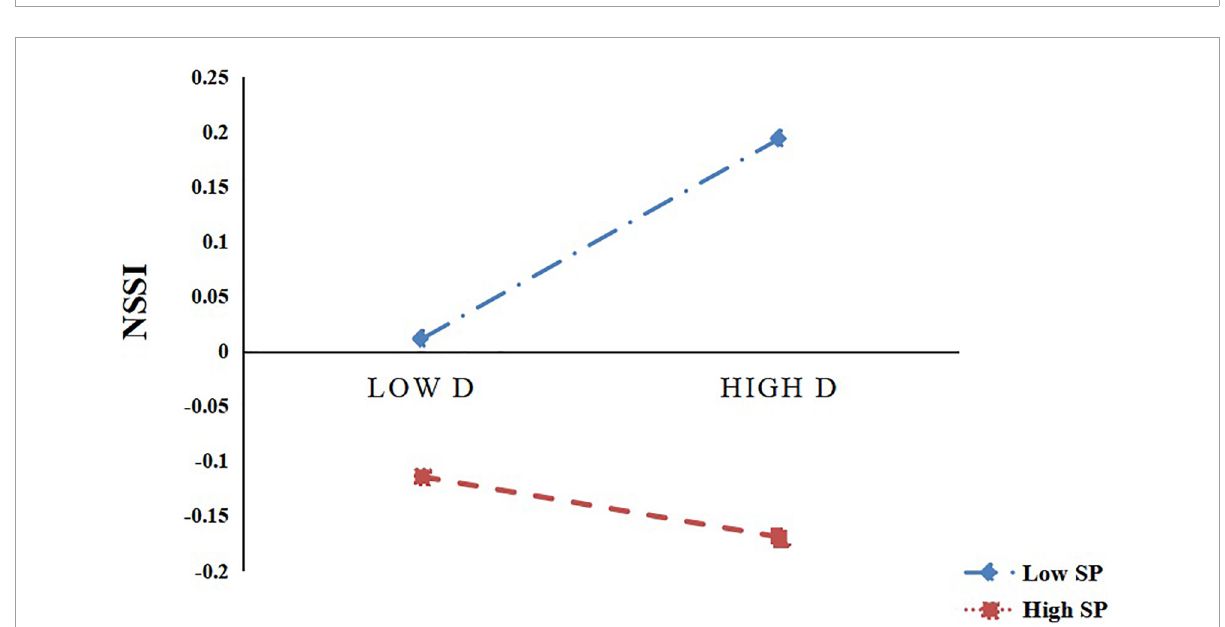
FIGURE4 Parental support as a moderator between catastrophising and NSSI ( N = 401, where D is catastrophising, SP is parental support, NE is negative affect, and NSSI is non-suicidal self-injury).